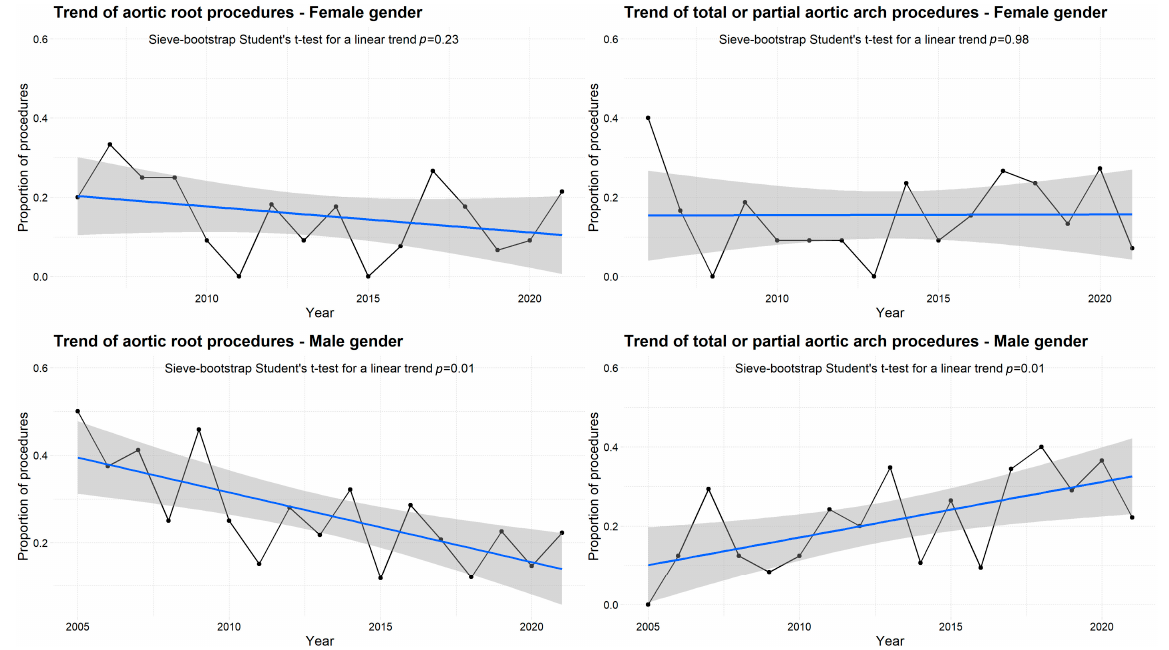
Figure 1. Trends in surgical procedures in male and female patients. Table 2. Early outcomes and the doubly robust matching estimators for confounding adjustment of the female and male patients.